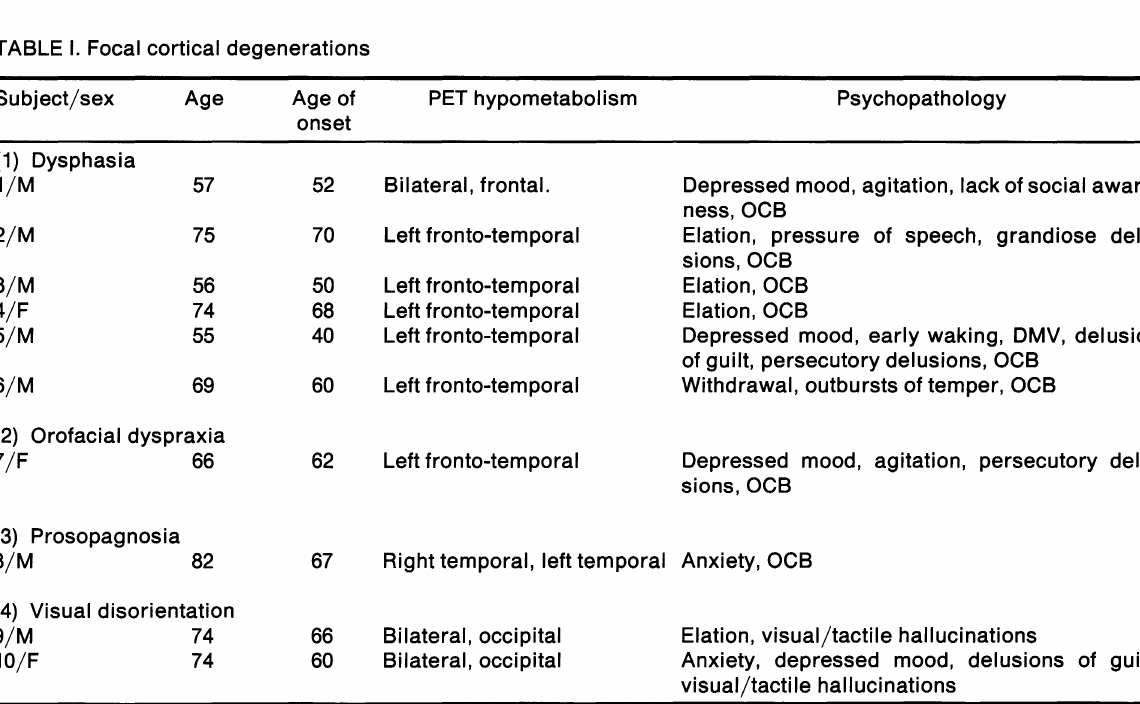
TABLE I. Focal cortical